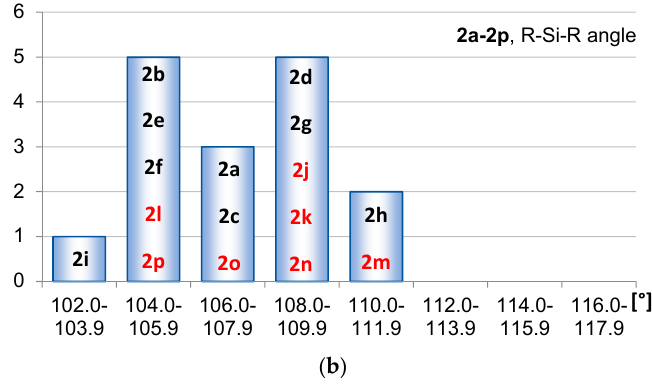
Figure 5. Distributions of the R-Si-R angles of ( a ) 1a – 1p and ( b ) 2a – 2p given in degrees and calculated at the PBE0/6-31G(d) level. The compound numbers substituted at the Si atoms are displayed in black and those substituted at the C atoms in red.